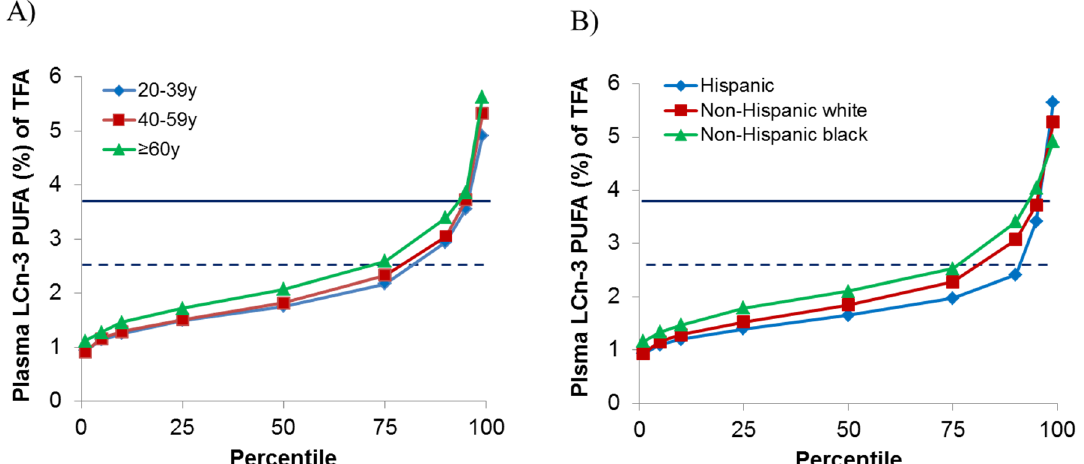
Figure 1. Serum long chain n ‐ 3 fatty acids by age ( A ) and race/ethnicity ( B ) in NHANES 2003–2004. Sum of eicosapentaenoic acid, docosahexaenoic acid and docosapentaenoic acid/total fatty acids. The solid line represents LCn ‐ 3 PUFA of 3.86%, the lower range of LCn ‐ 3 in the second tertile from Virtanen et al. [17] that was associated with 53% lower risk of sudden cardiac death. The dashed line represents LCn ‐ 3 PUFA of 2.49% a concentration approximately equal to dietary recommendations [1,5,7].